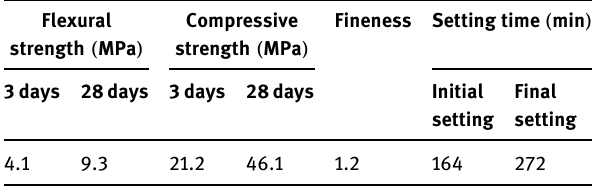
Table 1: Mechanical properties of Portland cement ( MPa )